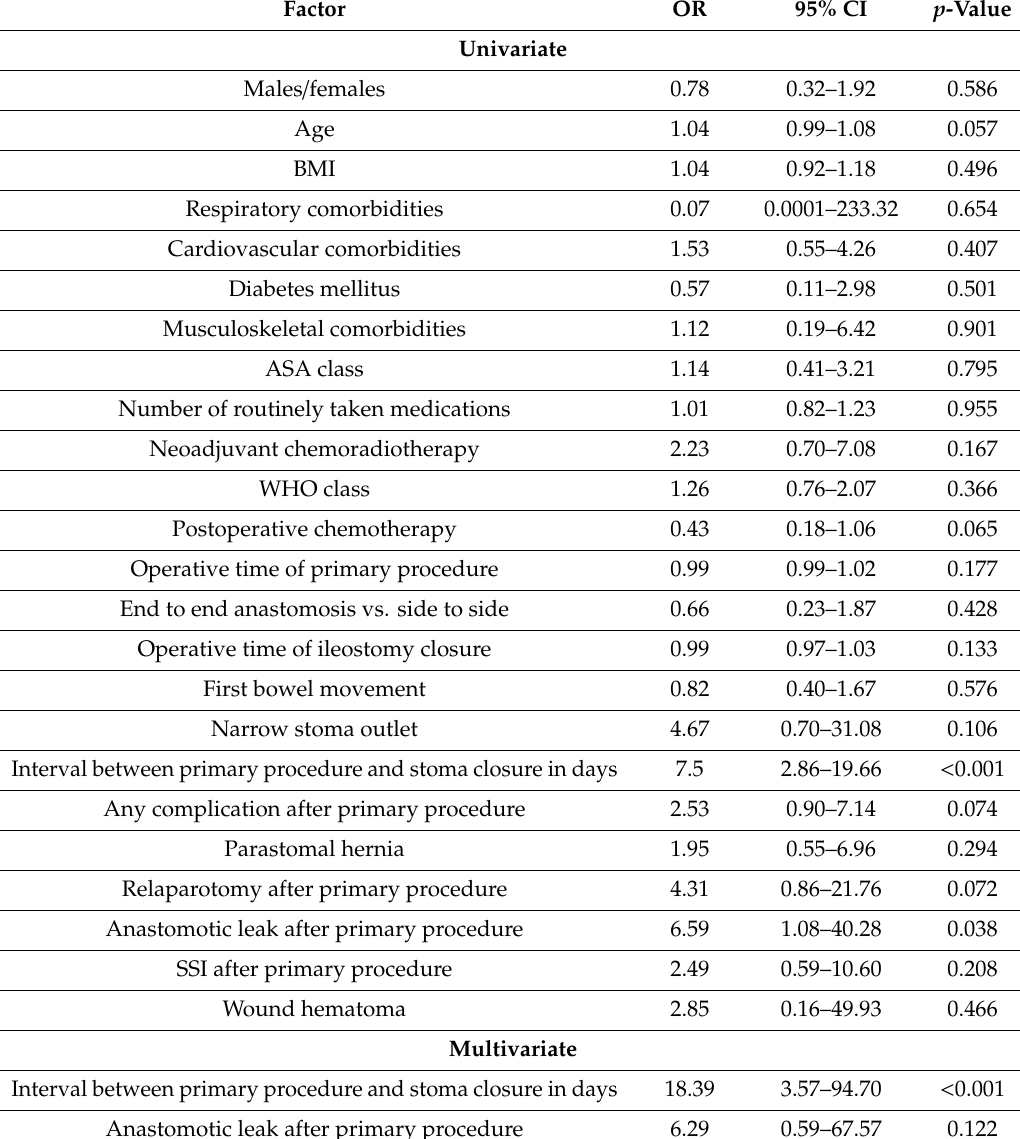
Table 5. Univariate and multivariate logistic regression models analysing factors potentially influencing